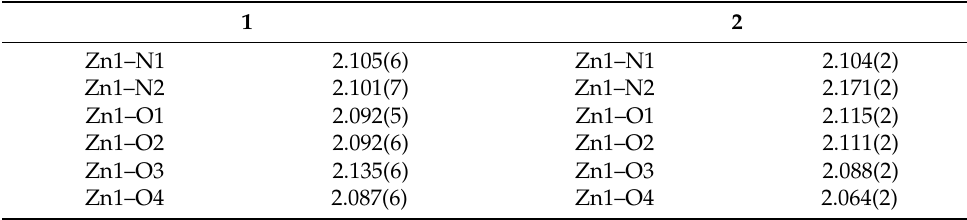
Figure 1. ( a ) Crystal structure of [Zn(hfac) 2 (2-PyBTD)] ( 1 ) with a focus on the coordination sphere of Zn II and partial atom numbering scheme; ( b ) Supramolecular dimer built out of mononuclear units of opposite chirality (green— Λ configuration, violet— Δ configuration) through π – π stacking clear units of opposite chirality (green— Λ configuration, violet— ∆ configuration) through π – π interactions. stacking interactions. Table 1. Selected bond lengths (Å) for compounds 1 and 2